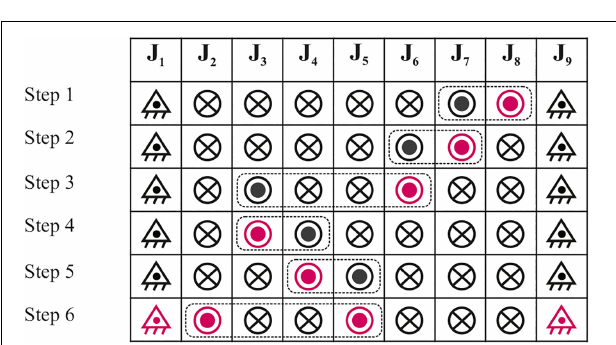
FIGURE 2 | The planar 9-bar linkage in its initial and target position.